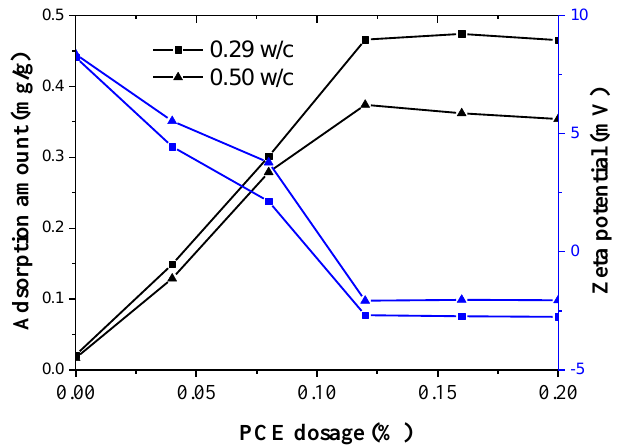
Figure 12. Adsorption behaviors and zeta potentials of the PCEs in the two w/c cement pastes.